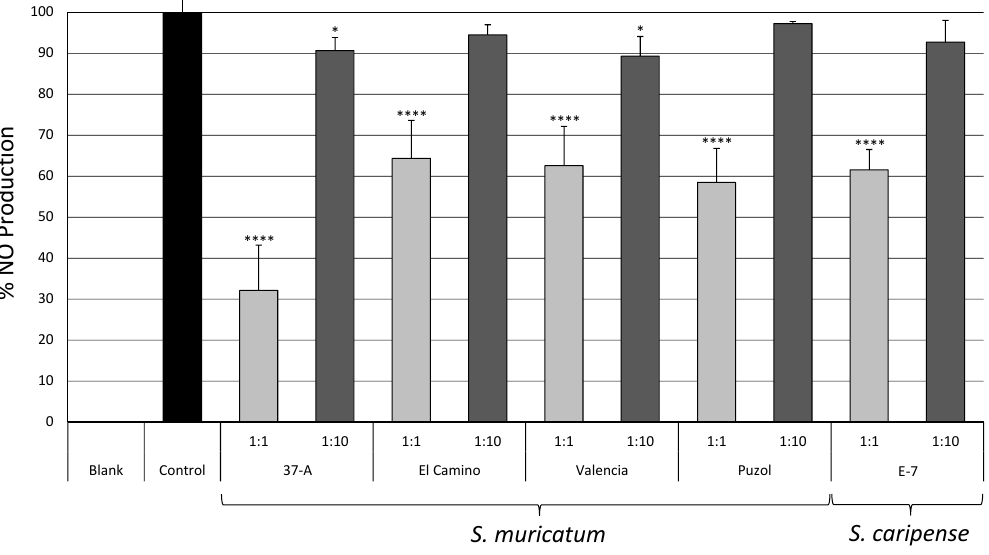
Figure 3. Percentage of nitric oxide (NO) production of lipopolysaccharide (LPS) stimulated RAW 264.7 macrophages incubated in raw (1:1; light grey columns) and diluted (1:10; dark grey columns) methanolic extracts of pepino and S. caripense accessions compared to a control with no extract (relative production of the control is assigned a value 100%). Bars represent ± SE ( n = 5) of the mean. Columns tagged with asterisks indicate that the mean values are significantly different from the control (**** and * indicate significance at p values of 0.0001 and 0.05, respectively) according to the Dunnett’s multiple comparison test.